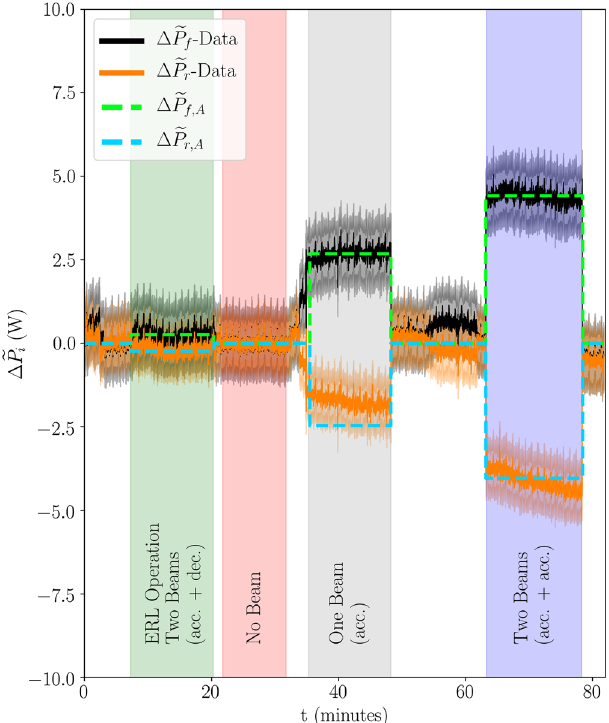
FIG. 9. Curves of the forward (black) and reverse (orange) power data including uncertainties marked as areas. The dashed lines show the curves extracted from the analytical model via curve fitting. The analytical curves show the theoretical behavior of forward (green) and reverse power (blue) in absence and presence of the beam (steps).